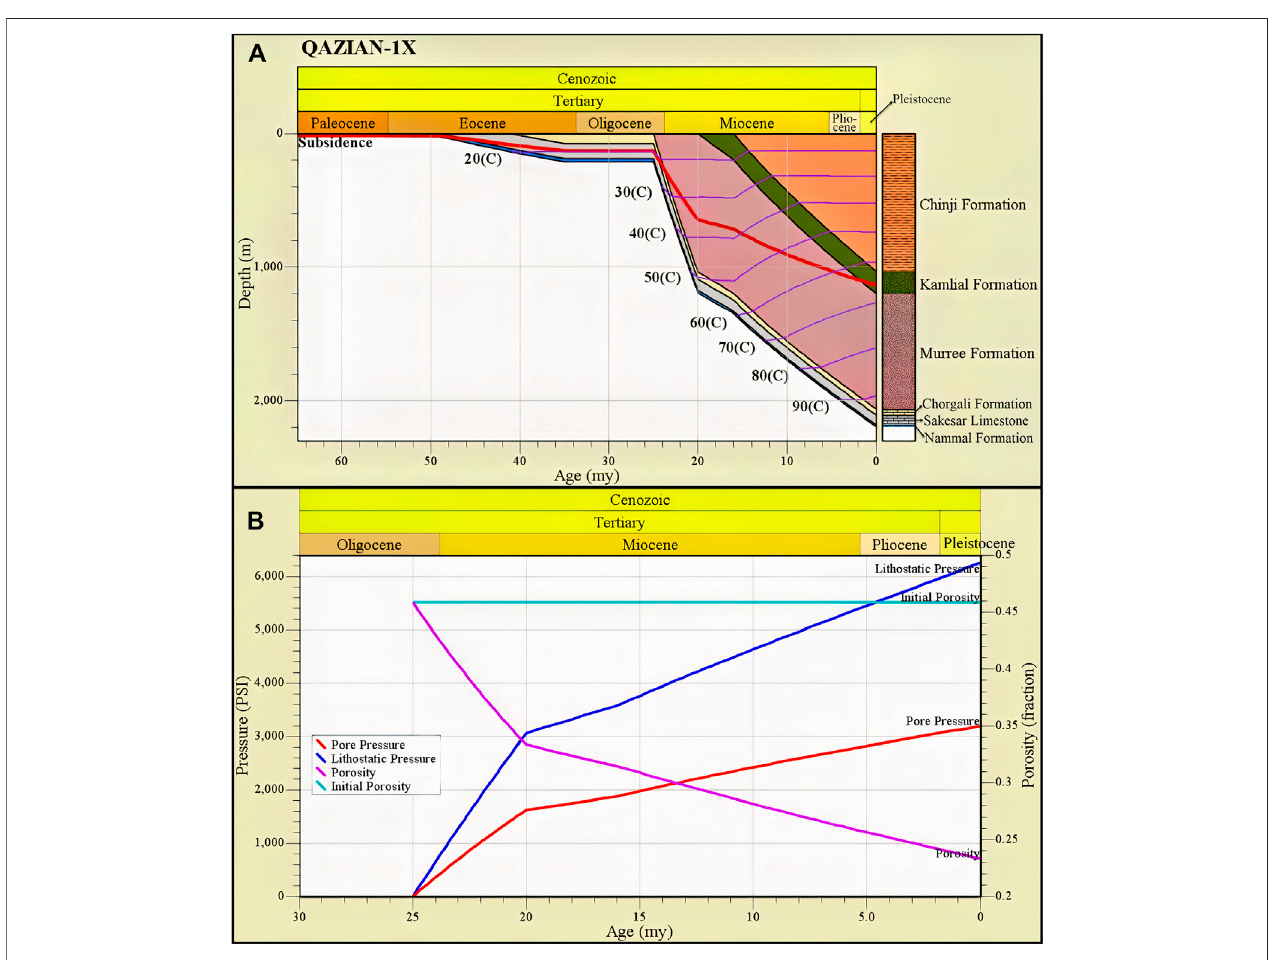
FIGURE9| Burialhistoryplot (A) andtheeffectoflithostaticpressureonporosityandporepressure (B) ofMurreeFormationinQazian-1X.In (A) Subsidencecurve (red) depicts theincrease intheburial depthduringMioceneage resulting fromthehighrateofsedimentationofNeogenemolasse deposits. In (B) ,anabrupt increase in pore pressure and decrease in porosity can be observed between 25 and 20 my due to the high rate of sedimentation and increase in lithostatic pressure. Porosity of Murree Formation decreased from 0.46 (initial porosity) to 0.23 (current porosity) due to overburden pressure with an increase up to maximum pressure of about 3200